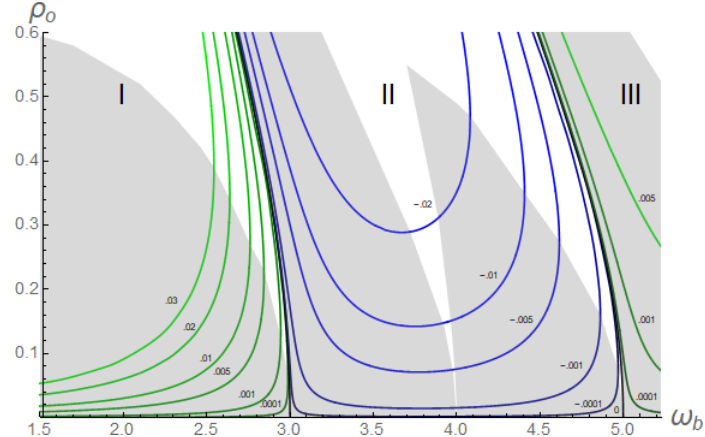
Figure 33 . Level curves of the SPS surface plotted in (cid:12)gure 32. Each curve corresponds to a constant value (cid:26) b (reported explicitly by a small number near the curve). Solutions belonging to shaded (white) regions are linearly stable